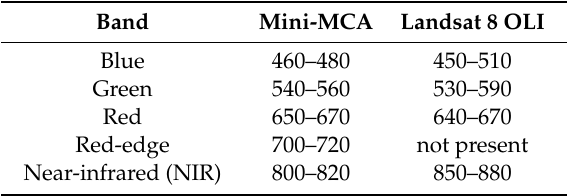
Table 1. Minimum and maximum wavelengths (nm) for bands of the Tetracam, Inc. Miniature Multiple